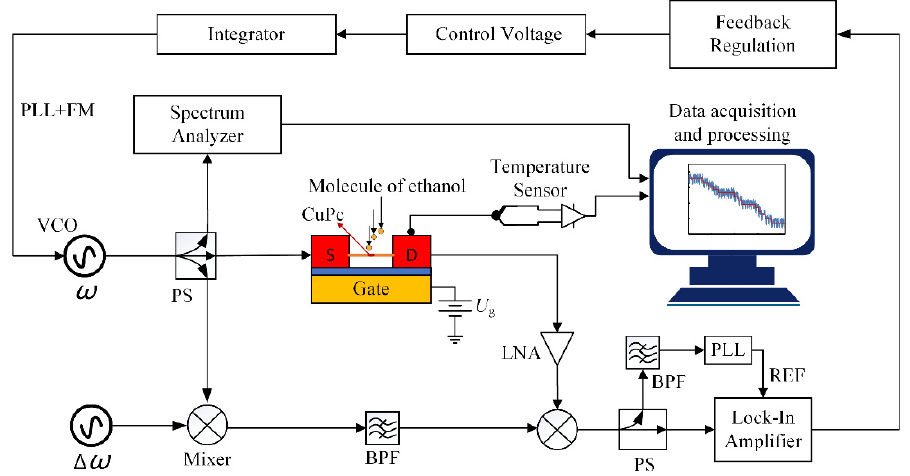
Figure 3. Closed loop detection circuit of the ZnO NW sensor.